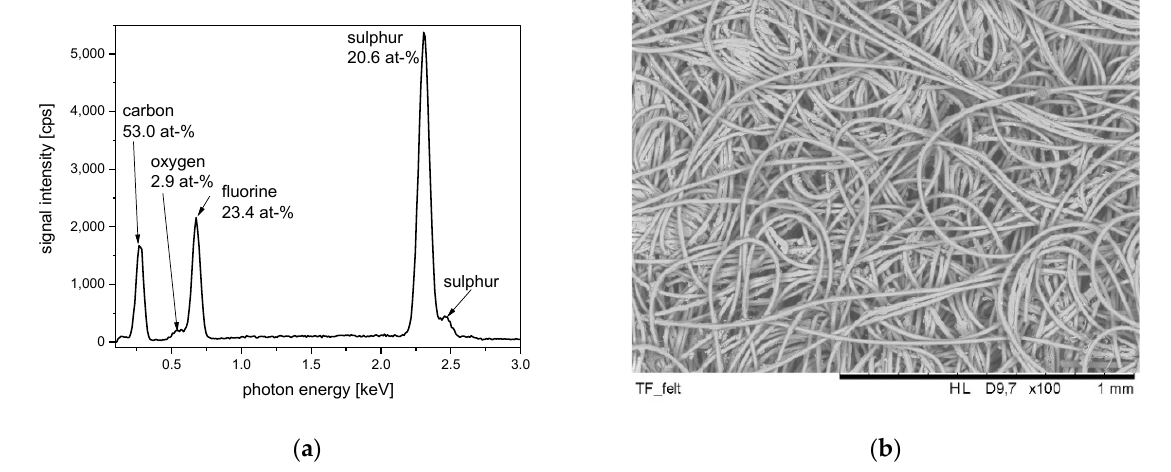
Figure 13. PPS sample from a non-woven filter material with fluoro carbon finish — ( a ) EDS spec- trum; ( b ) SEM image.